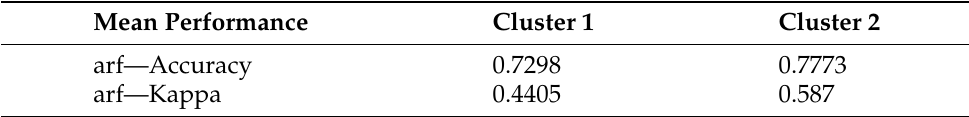
Table 2. Prequential evaluation of online adaptive random forest (ARF)